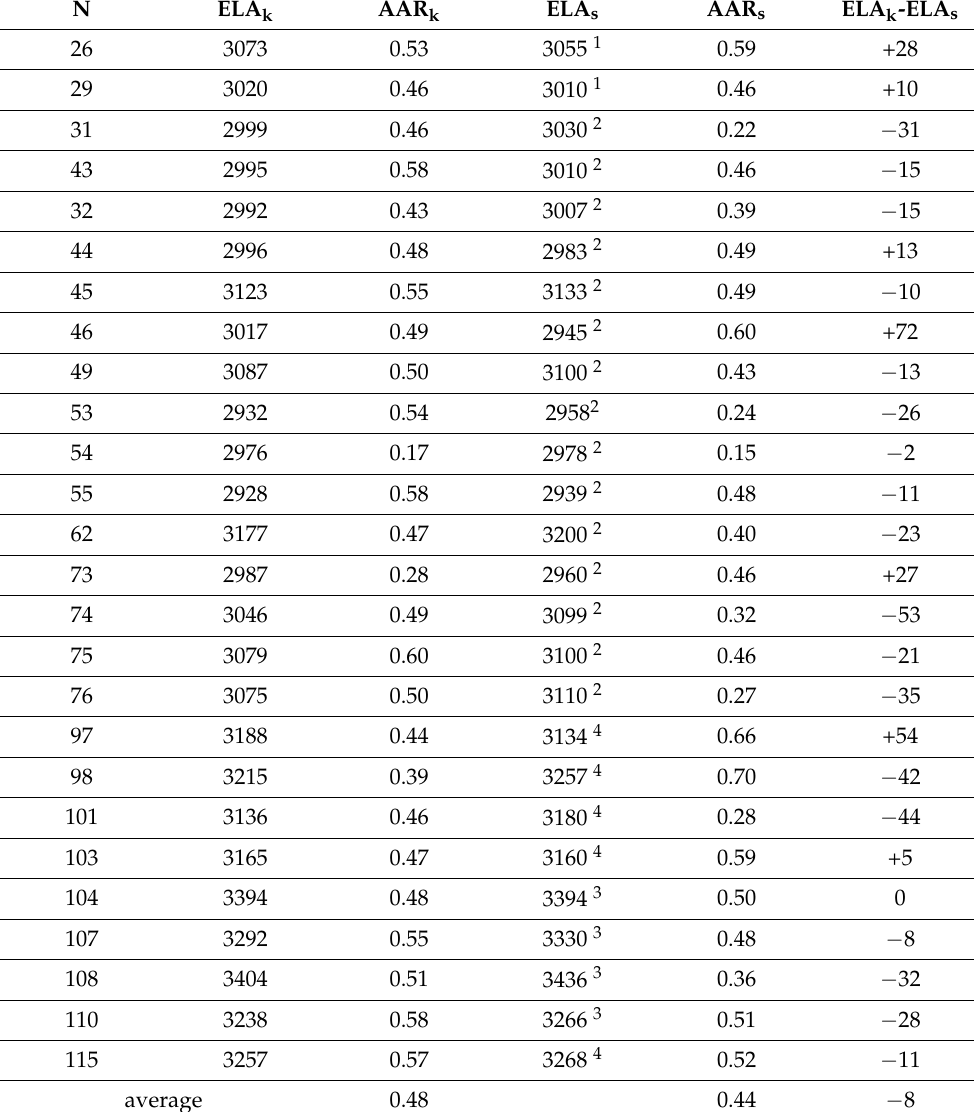
Table 2. Comparison of the results of ELA and AAR estimation by Kurowski method and obtained from satellite imagery for the glaciers of Shapshalsky ridge. N ELA k AAR k ELA